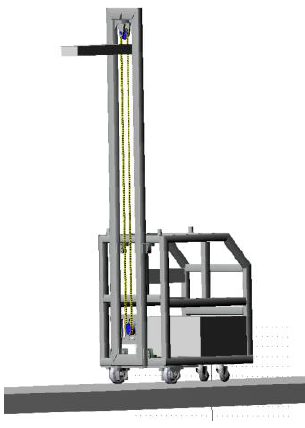
Figure 7. Fork-type AGV model.